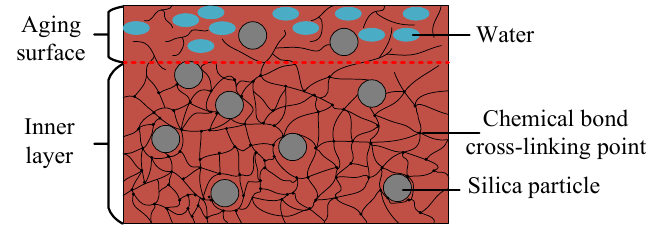
Figure 20. Water intrusion model